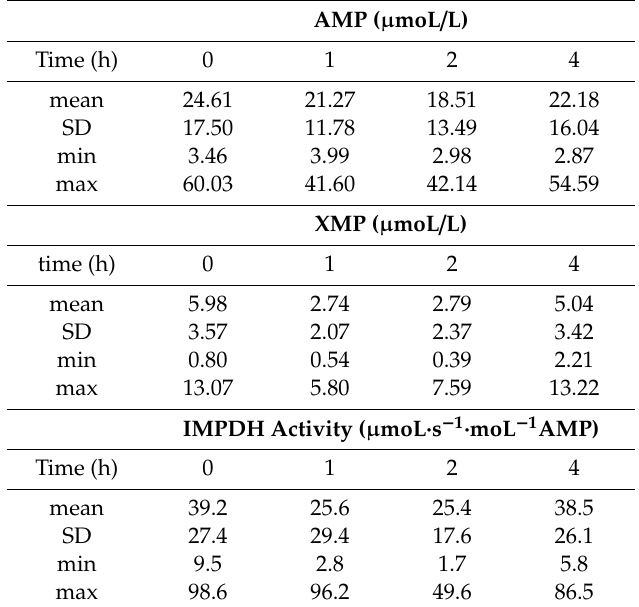
Figure 2. Inosine 5’-monophosphate dehydrogenase (IMPDH) activity in peripheral blood mononuclear cells (PBMCs) from child No. 2 ( a ) and No. 5 ( b ) after incubation with nicotinamide adenine dinucleotide (NAD + ) at a concentration of 0.5 mmoL/L (white bar) and 1.0 mmoL/L (black bar).